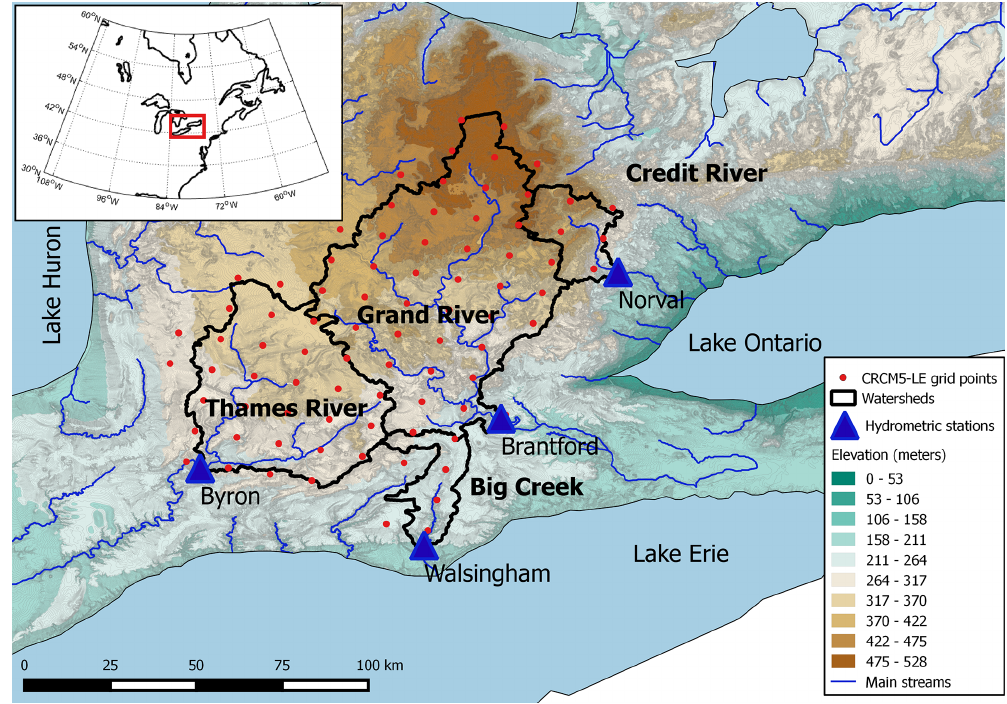
Figure 1. Location map of the four studied watersheds in southern Ontario. Elevation source: High Resolution Digital Elevation Model (HRDEM; Natural Resources Canada). Table 1. Geomorphic, land use and soil characteristics of the four watersheds examined in this study. Size Altitude Land use (%) Soil type (%) (km 2 ) (m) Urban or barren Forest Shrub Crops or grass Sand Loam Clay Big Creek